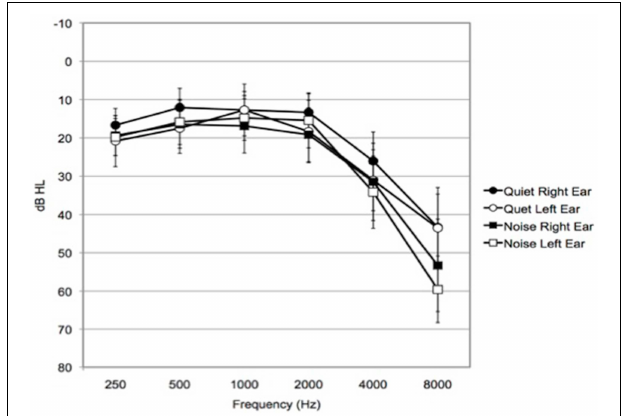
FIGURE 1 | Mean audiogram profile. Hearing thresholds of all participants in this study. Mean audiogram profile of Quiet group right ear and Quiet group left ear ( n = 24 ), Noise group right ear and Noise group left ear ( n = 24 ). Bars represent 95% confidence